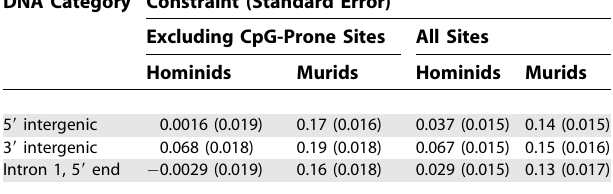
Table 2. Constraint in Hominids and Murids Calculated for Datasets Excluding CpG-Prone Sites and for Datasets Including